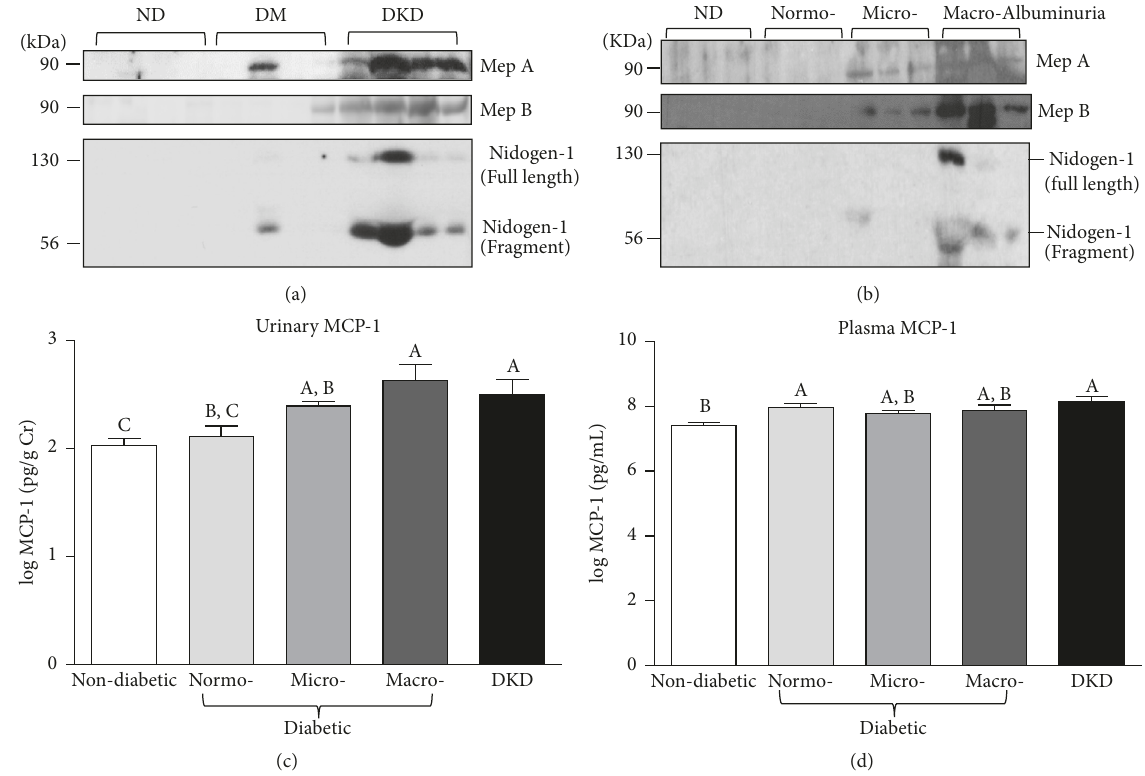
Figure 7: Urinary meprin A, meprin B, nidogen-1, and monocyte chemoattractant protein-1 (MCP-1). (a) Representative immunoblots for urinary meprin A, meprin B, and nidogen-1 grouped according to diabetes status; nondiabetic controls (ND), diabetic patients with no known kidney disease (DM), and patients with diagnosed diabetic kidney disease (DKD). (b) Representative immunoblots for meprin A, meprin B, and nidogen-1 in samples from nondiabetic controls (ND) and diabetic patients without known kidney disease grouped into normo-, micro-, and macroalbuminuria based on the UACR. (c)-(d) Log-transformed plasma (c) and urinary (d) MCP-1 levels among nondiabetic controls, diabetic patients with normo-, micro-, or macroalbuminuria, and patients with diagnosed diabetic kidney disease (DKD). Urinary MCP-1 was normalized to urinary creatinine. Data are represented as mean ± SEM. Labeled means without a common letter are significantly different from one another (𝑝 < 0.05) based on one-way ANOVA and Tukey’s honest significant difference test.